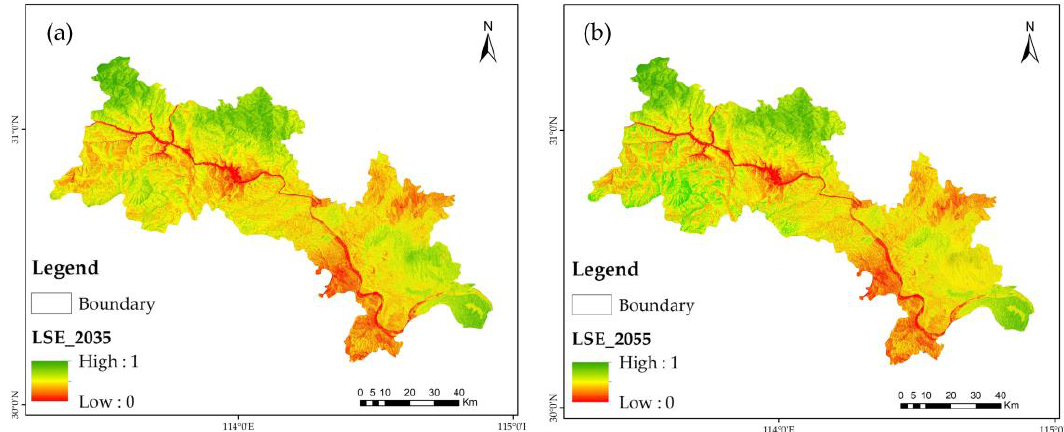
Figure 15. LSE Forecast Results. ( a ) LSP result for 2035; ( b ) LSP result for 2055.